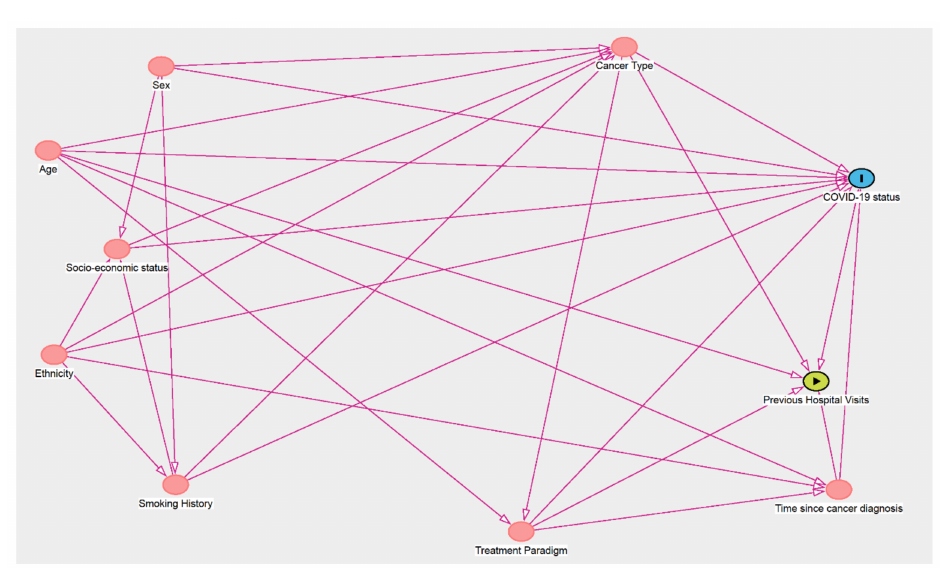
Figure A1. Directed Acyclic Graph (DAG) for the association between demographic and clinical factors and risk of COVID-19 in cancer patients (www.dagitty.net, accessed on 11 January 2021). Table A1. Overview of minimal adjustments for the associations between demographic and clinical characteristics and risk of COVID-19 or death in cancer patients (www.dagitty.net, accessed on 11 January